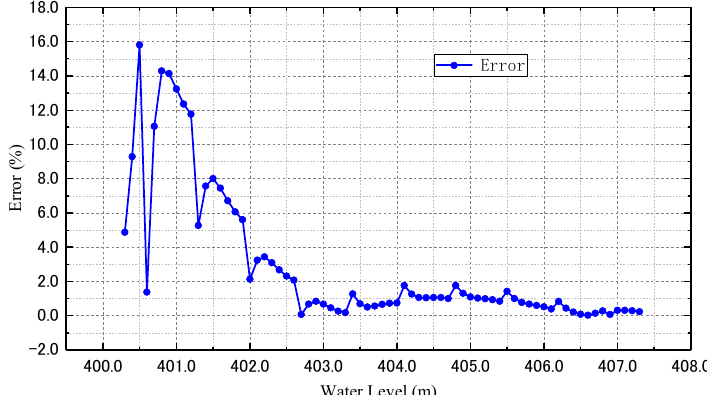
Figure 6. Figure on the errors of simplified and accurate algorithms in the free flow stage.